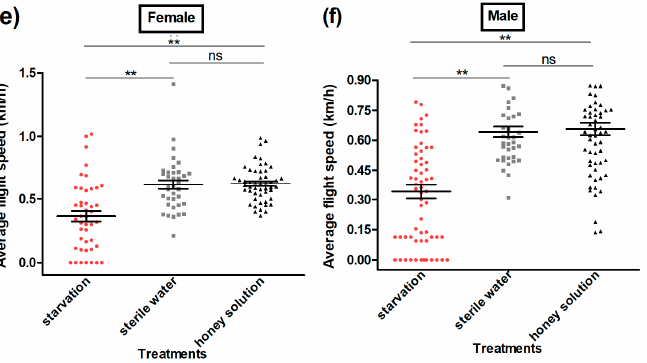
Figure 5. The maximum flight distance (m) ( a , b ), maximum flight duration (s) ( c , d ), and average flight speed (km/h) ( e , f ) of female and male Grapholita molesta moths under different feeding treatments. The data are shown as the mean ± standard error. **, significant difference at p < 0.01; ns, no significant difference.